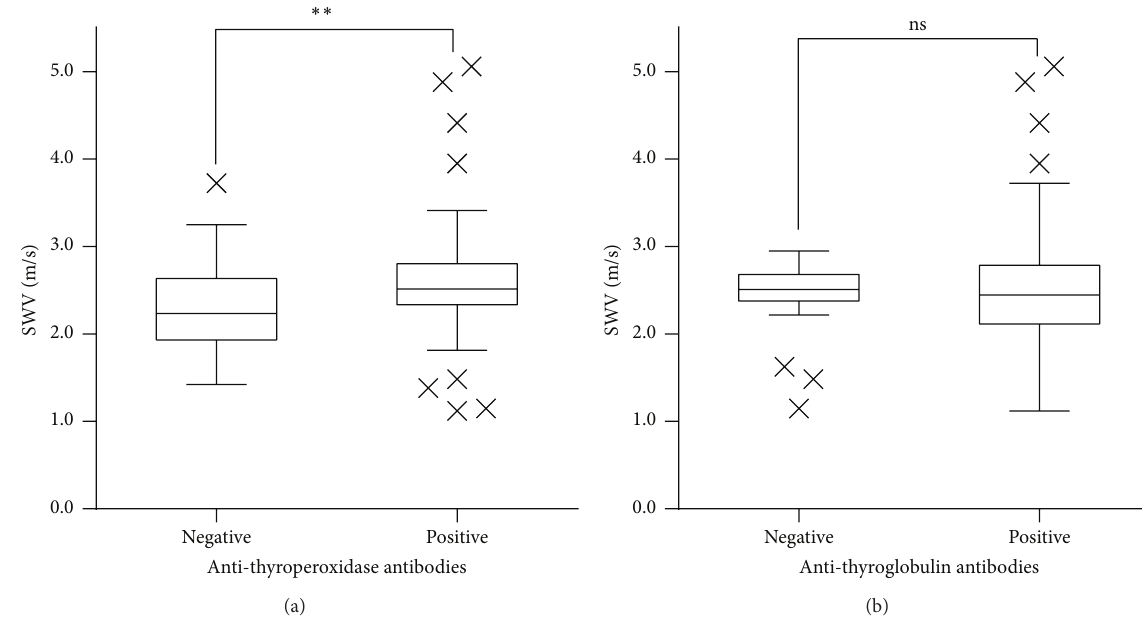
Figure 6: Box-and-whisker plots showing shear wave velocity by anti-thyroperoxidase and anti-thyroglobulin antibody status. (a) Note. ∗∗ 𝑃 < 0.01